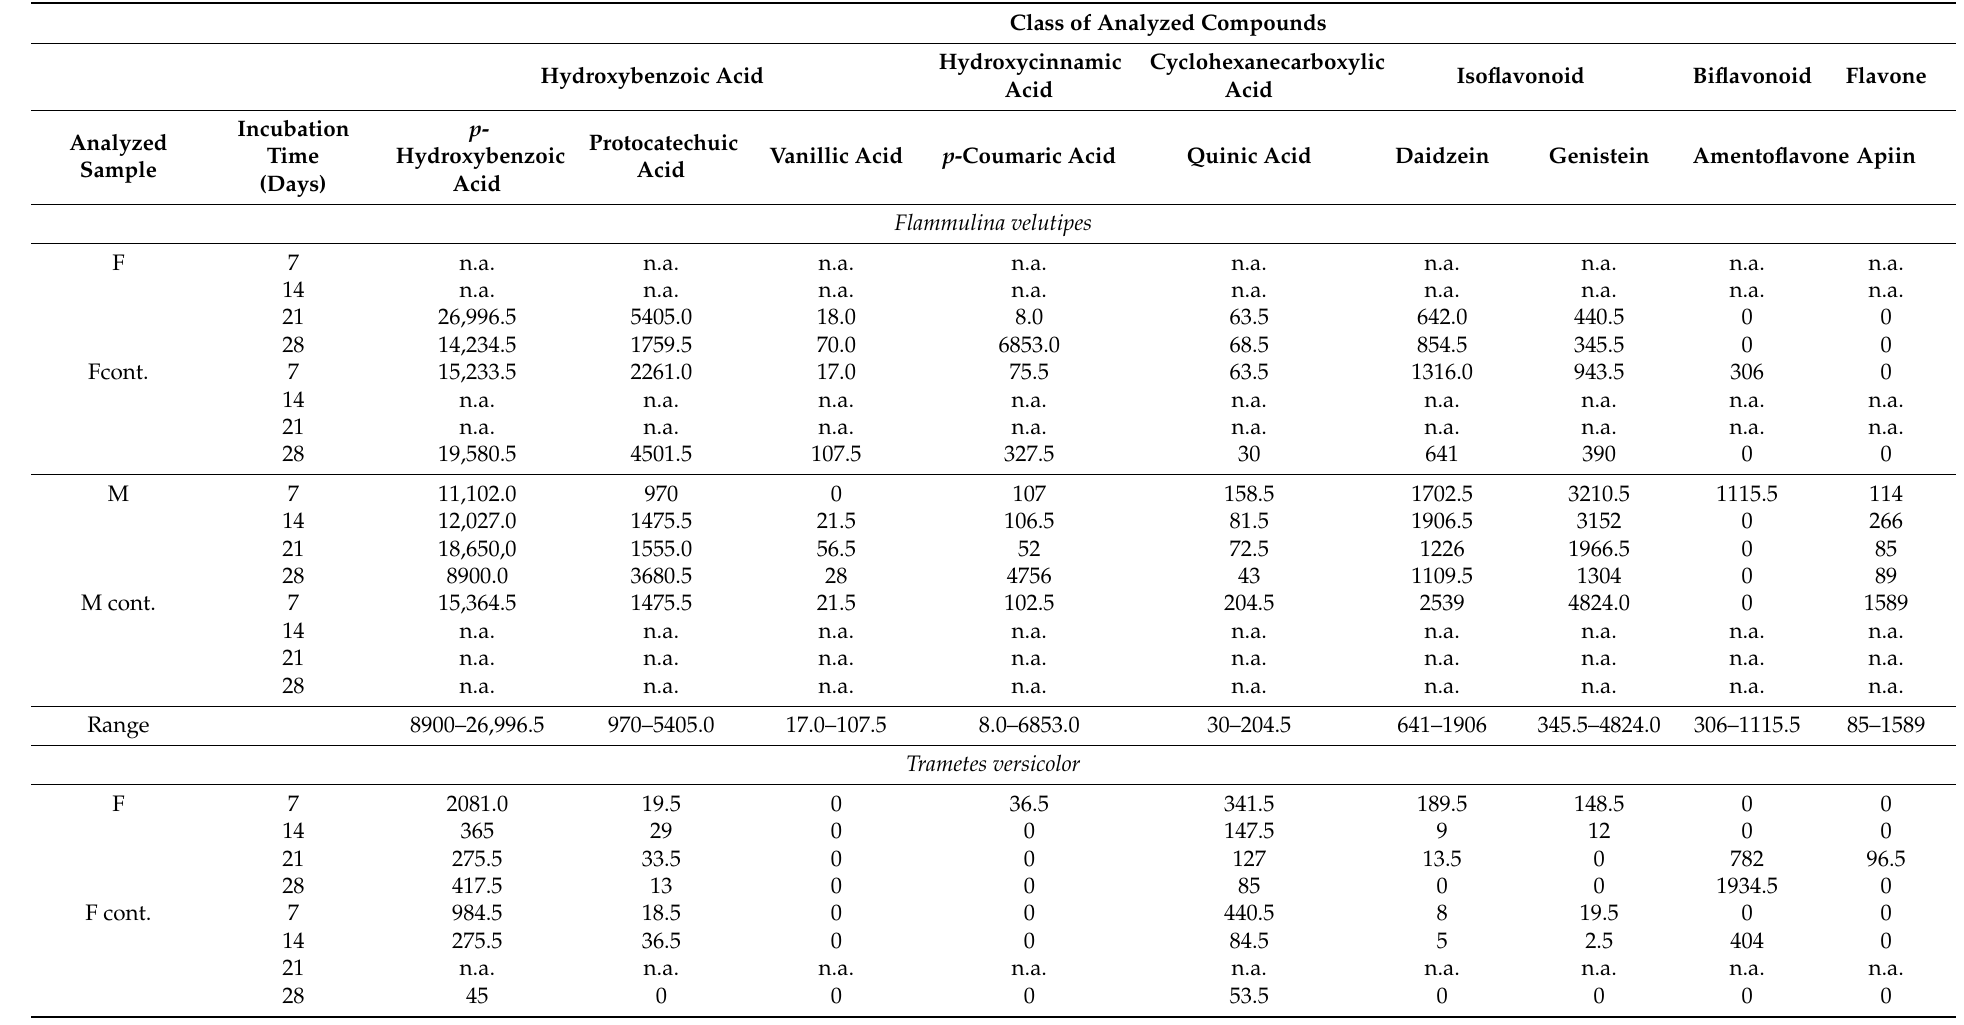
Table 1. Determined concentrations of selected phenolic compounds via LC–MS/MS method in examined EtOH extracts of F. velutipes and T. versicolor expressed as µ g/g